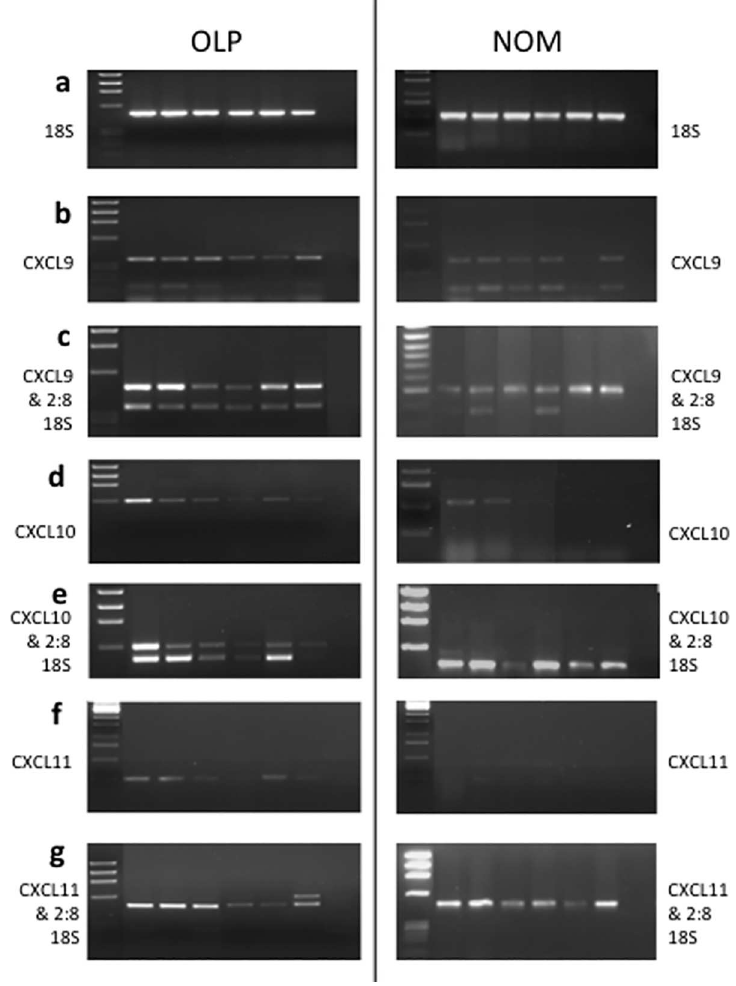
Fig 7. The semi-quantification of the CXC ELR- chemokines in oral inflammation. a) 18S, b) CXCL9, d) CXCL10and f) CXCL11 mRNA expressionin 6 samplesof oral lichenplanus (OLP) (as a representative of 12 different cases) and 6 samples of normal oral mucosa (NOM). c) CXCL9, e) CXCL10 and g) CXCL11mRNA expressionfor the same cases with a 2:8 ratio of 18S:competitor (2:8 18S).